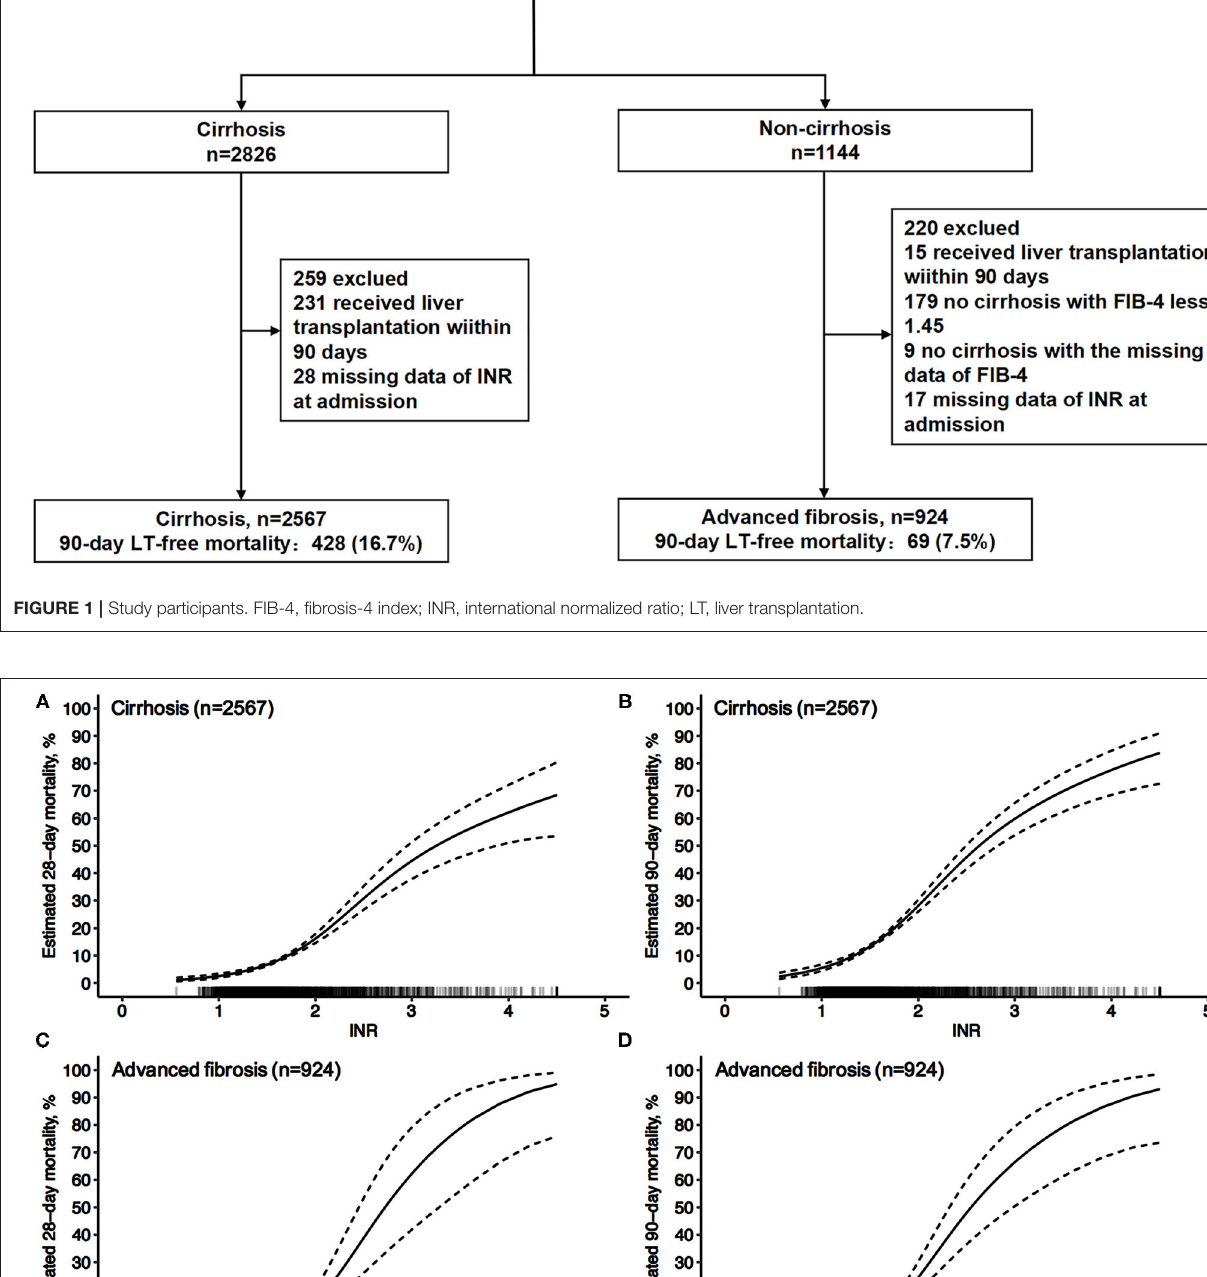
Frontiers in Medicine |